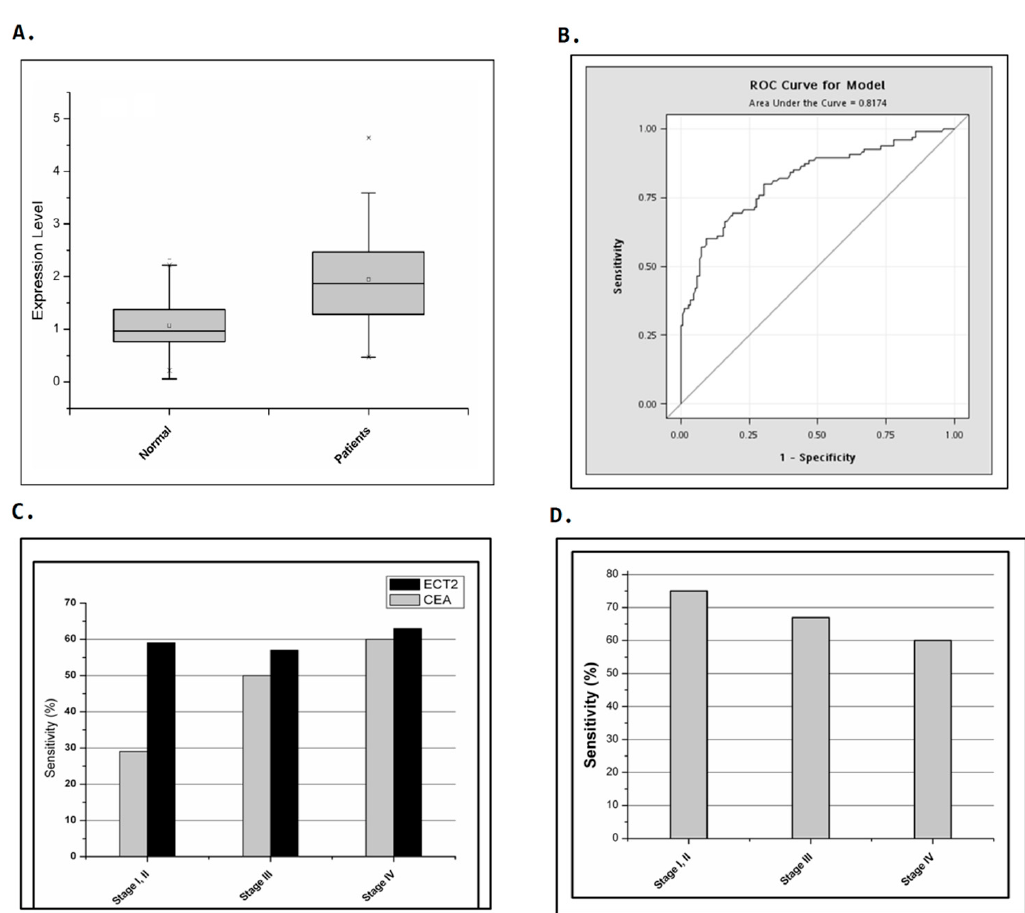
Figure 2. Identification of ECT2 as a candidate marker gene for quantifying circulating tumor cells in colorectal cancer patients. Comparison of the detection sensitivity of CEA and ECT2 , singly and in combination, as markers in colorectal cancer patients at different stages. ( A ) A box plot showing differential expression ratios of ECT2 in colorectal cancer patients and a normal control group. The p value of a two-tailed unpaired t -test was 1.42 × 10 − 15 . The whiskers of the boxes indicate 1.5 interquartile range (IQR) of the lower and higher quartile. ( B ) Receiver operating characteristic (ROC) analysis of ECT2 expression in cells from peripheral blood of colorectal cancer patients and normal donors. The area under curve (AUC) was 0.821. ( C ) A total of 90 colorectal cancer patients were included in this study. CEA had a detection sensitivity of 29%, 50%, and 60%, while ECT2 had a sensitivity of 59%, 57%, and 63%, in patients with stage I/II, stage III, and stage IV cancers, respectively. ( D ) In patients with serum CEA lower than the diagnostic threshold of 5 ng/mL, the ECT2 quantification sensitivity in patients with stage I/ II, stage III, and stage IV were 75%, 67%, and 59%.